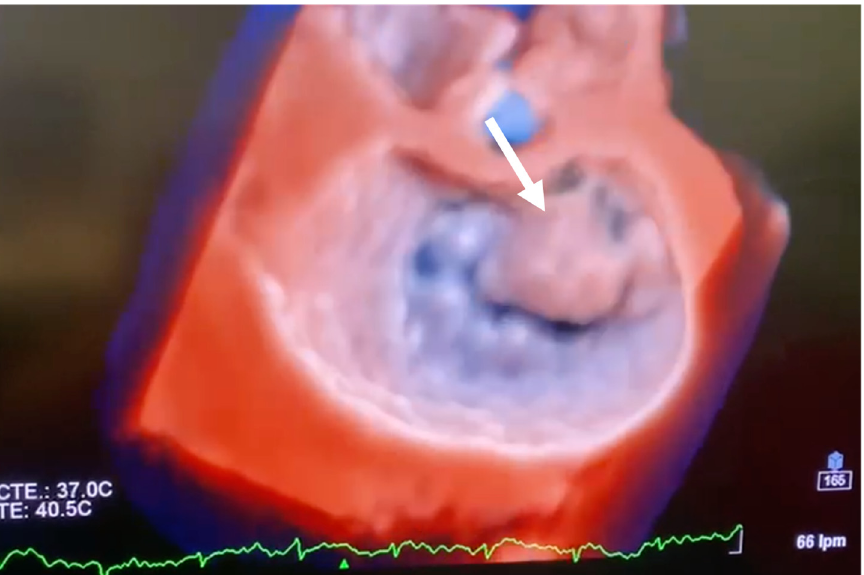
Figure 2. Transoesophageal echocardiographic short axis 3D view (surgical view) illustrating anterior leaflet prolapse (white arrow).